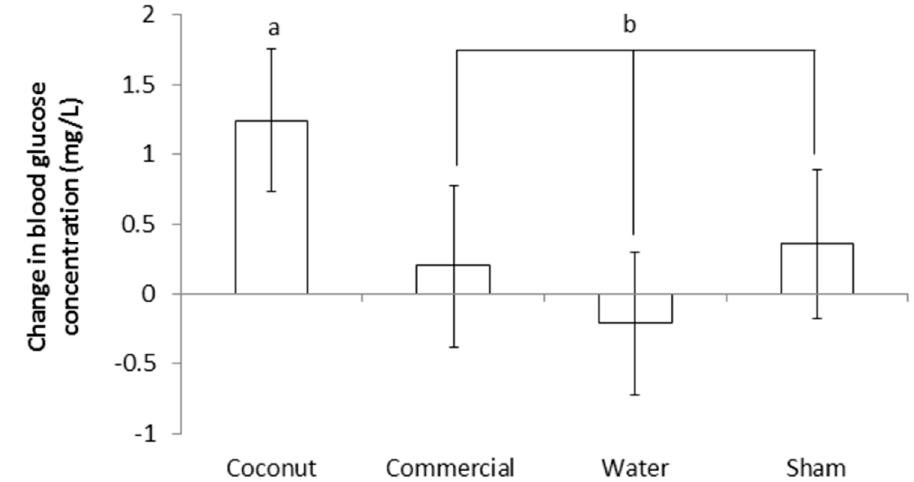
Figure 4. Change in blood glucose concentration during the 24 h following assignment to treatments (i.e., at 3 h postpartum). Piglets were either given a 2 mL oral supplementation at 3 h postpartum (coconut oil, commercial product or water) or were sham-dosed. Di ff erent superscript letters (a and b) indicate significant difference between treatments ( p < 0.05).